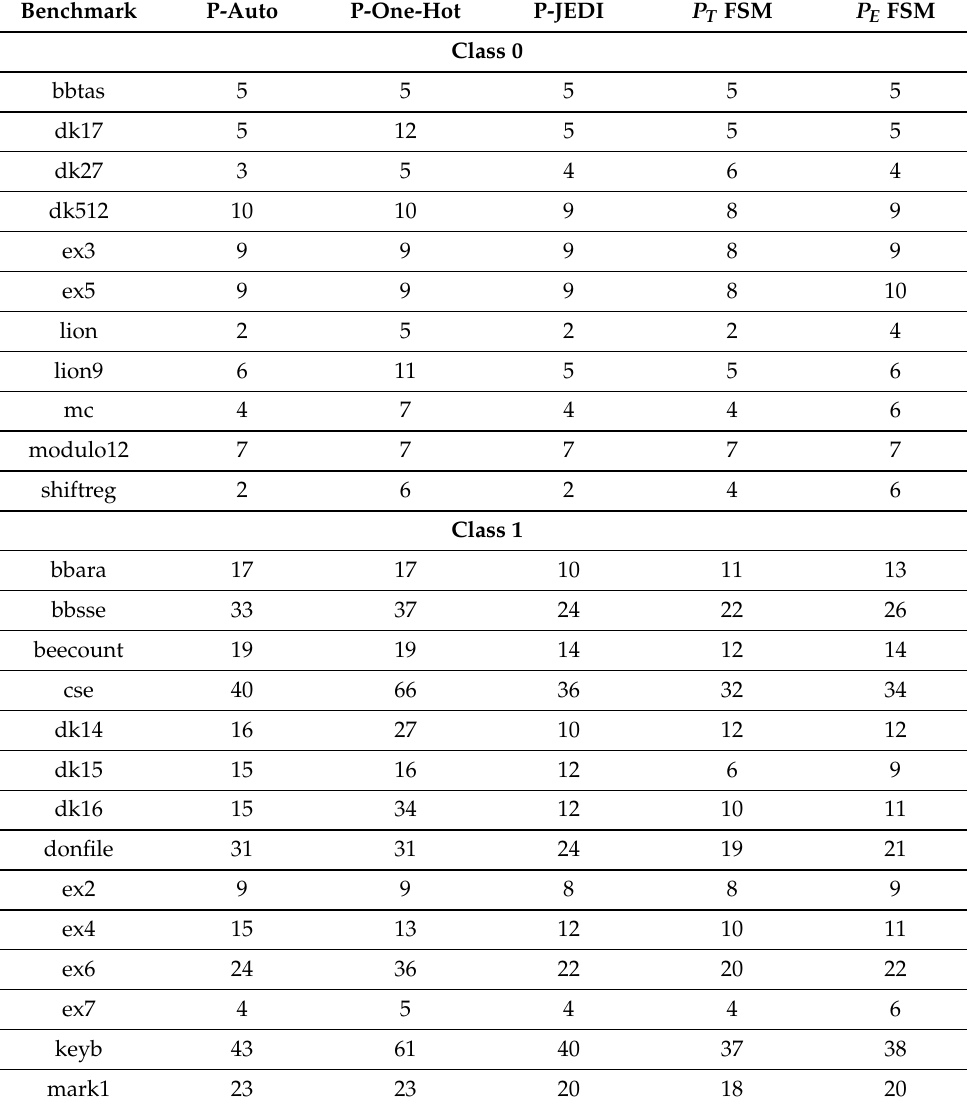
Table 7. Experimental results (the number of